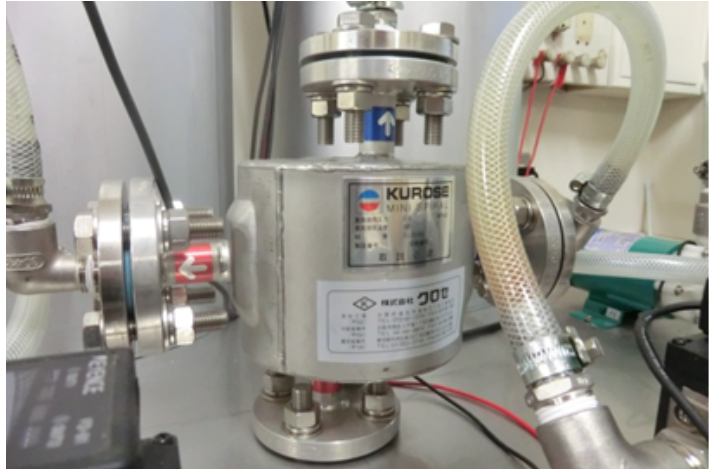
Figure A1. A spiral heat exchanger plant.